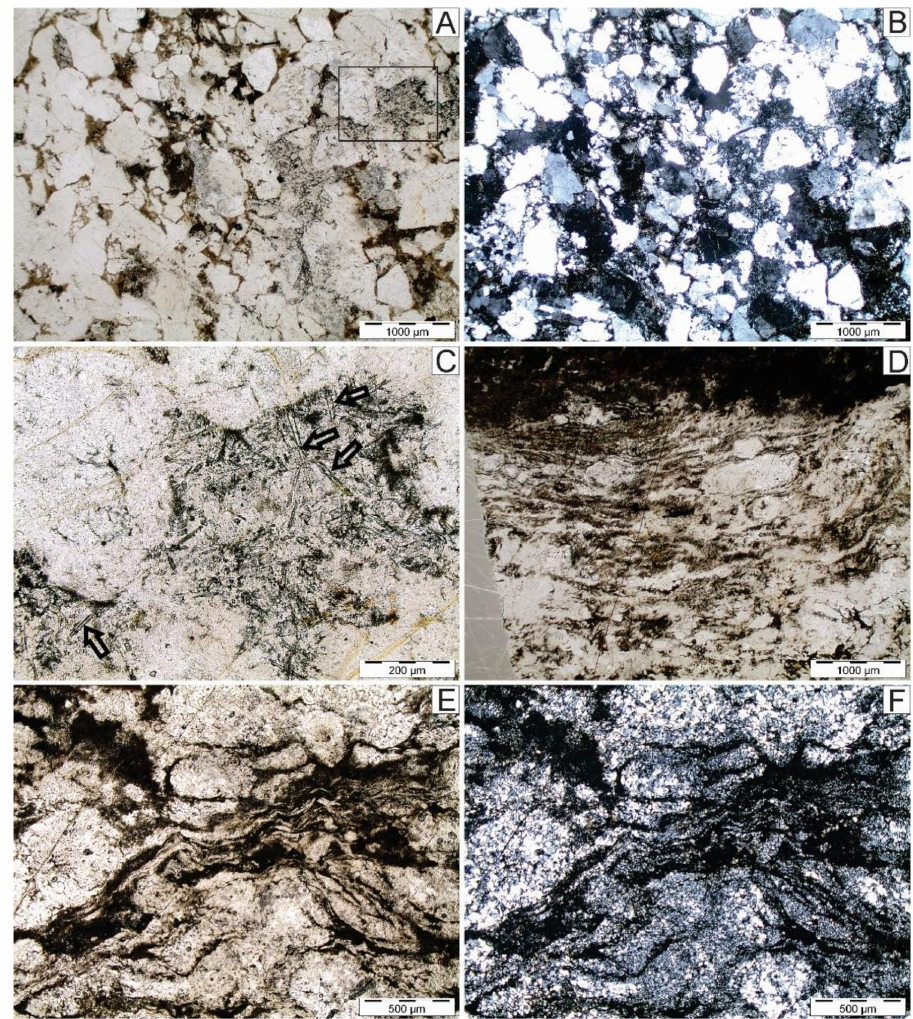
Figure 2. Transmitted light images of the sample. ( A ) Domain with massive texture, away from the PT vein. Pockets of granophyre are locally observed (rectangle), plain-polarized light (PPL). ( B ) Same area as in ( A ), cross-polarized light (XPL). ( C ) Pocket filled with granophyre (dark), the enlarged area, as shown in ( A ). Orthopyroxene needles are notable (arrows), PPL. ( D ) Foliated domain, adjacent to PT vein (black in the upper part of the image), PPL. ( E ) Domain, adjacent to the PT vein, signs of partial melting of dark phases, PPL. ( F ) Same area as in ( E ), XPL. Quartz is polycrystalline (mosaic) and inter-fingers with dark